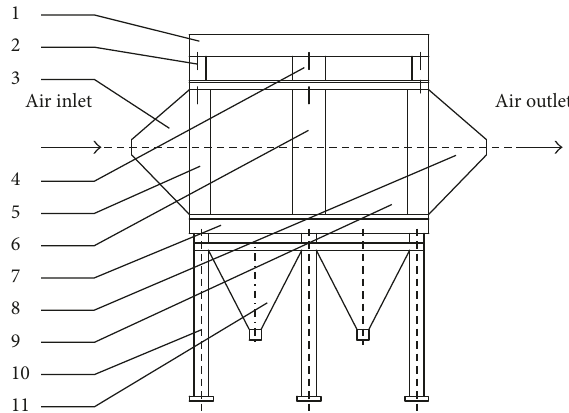
Figure 1: The schematic sketch of main structure of electrostatic precipitator. (1) Top lifting cradle, (2) narrow girder, (3) inlet smoke box, (4) wide girder, (5) narrow column, (6) wide column, (7) bottom beam, (8) outlet smoke box, (9) side wall, (10) bottom bracket, (11) ash bucket.